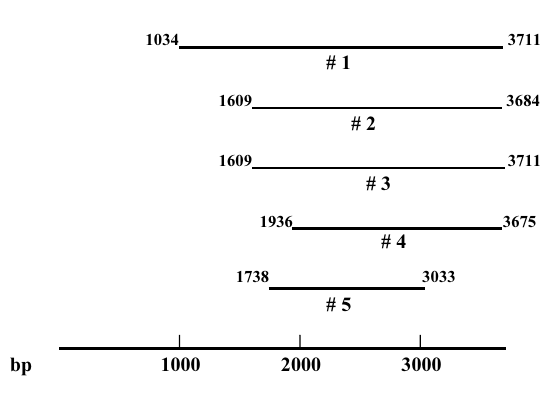
Figure 2 Overlapping monkey cDNA clones containing monkey LTBP- 3 sequence. The numbers displayed next to each clone rep- resent the nucleotides of the cDNA clone. The numbering system is based on that presented for the mouse LTBP-3 cDNA sequence in which the A of the intitiator Met codon is nucleotide 1 (Yin et al. 1995). The fusion proteins encoded by each of the cDNA clones demonstrated interaction with the extracellular domain of proHB-EGF when tested for β - galactosidase activity using the yeast two-hybrid system